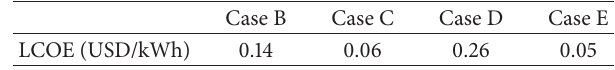
Table 4: LCOE for four different cases.